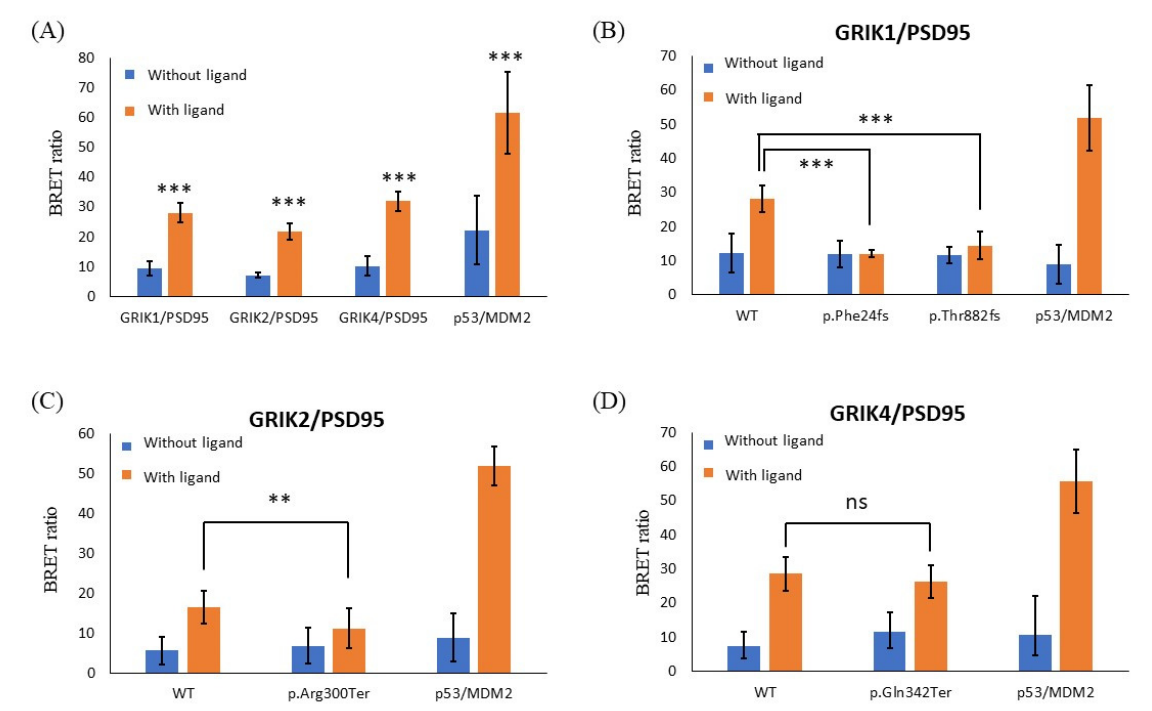
Figure 4. NanoBRET assay to detect the interaction between GRIK and PSD95 protein in live cells. ( A ) GRIK1, GRIK2, and GRIK4 proteins were associated with PSD95 protein by measuring energy transfer from a bioluminescent protein donor to a fluorescent protein acceptor. The p53/MDM2 was a positive control. Differences in BRET ratio between with and without NanoBRET™ HaloTag ® 618 Ligands were assessed using Student’s t -tests. ( B , C ) The three mutants ( GRIK1 p.Phe24fs , GRIK1 p.Thr882fs , and GRIK2 p.Arg300Ter ) significantly weakened or even abolished the interaction among themselves and with the PSD95 protein, whereas the interaction of GRIK WT proteins with PSD95 was preserved. ( D ) The interactions of GRIK4 WT and mutant-type ( GRIK4 p.Gln342Ter ) proteins with PSD95 were pre- served. Graphs represent means ± standard deviation. *** p < 0.001, ** p < 0.01, ns means nonsignif- icant.